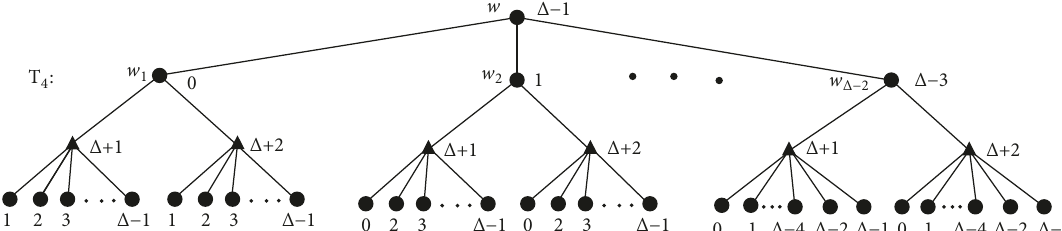
Figure 7: Irreducible 𝐿(2, 1) -span coloring of 𝑇 4 with one